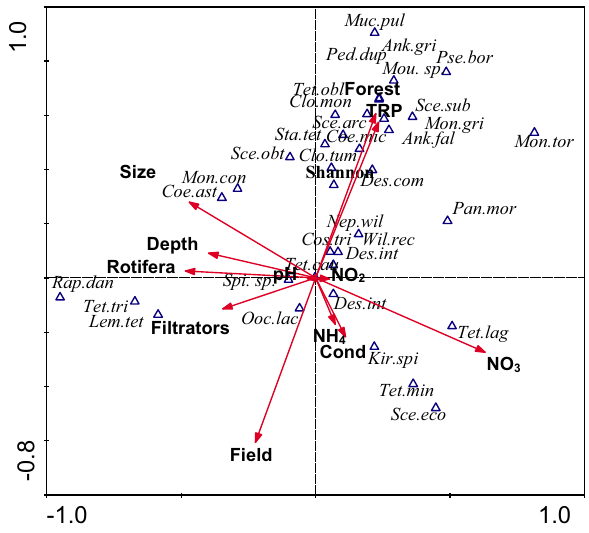
Figure 1. CCA diagram of the distribution of chlorophyte dominating species and diversity (Shannon— Shannon–Wiener Diversity Index) in relation to environmental factors in field and forest ponds.